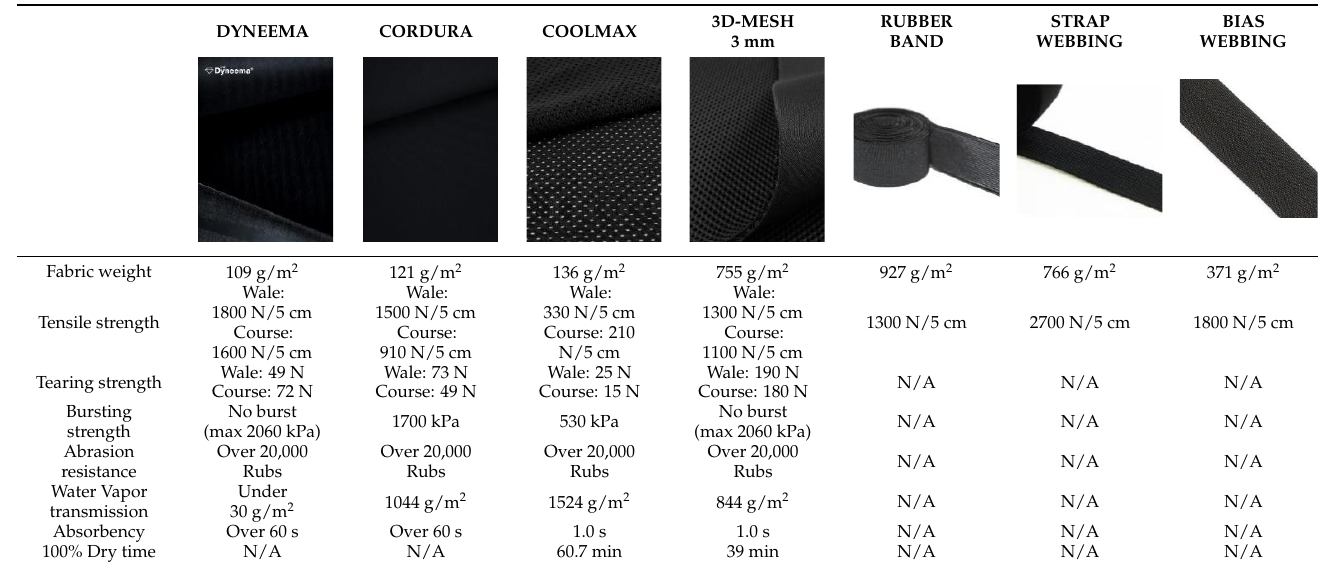
Table 1. For each pattern of kneE-XOcks, fabrics and materials that match the characteristics of the body anatomy targeted for the bio-inspired pattern design were used. High stiffness fabrics and materials such as Dyneema and Cordura or webbing are used for force transmitting and supporting patterns. Fabric and material such as Coolmax with high breathability or rubber band were used for patterns that consider the wearer’s convenience.